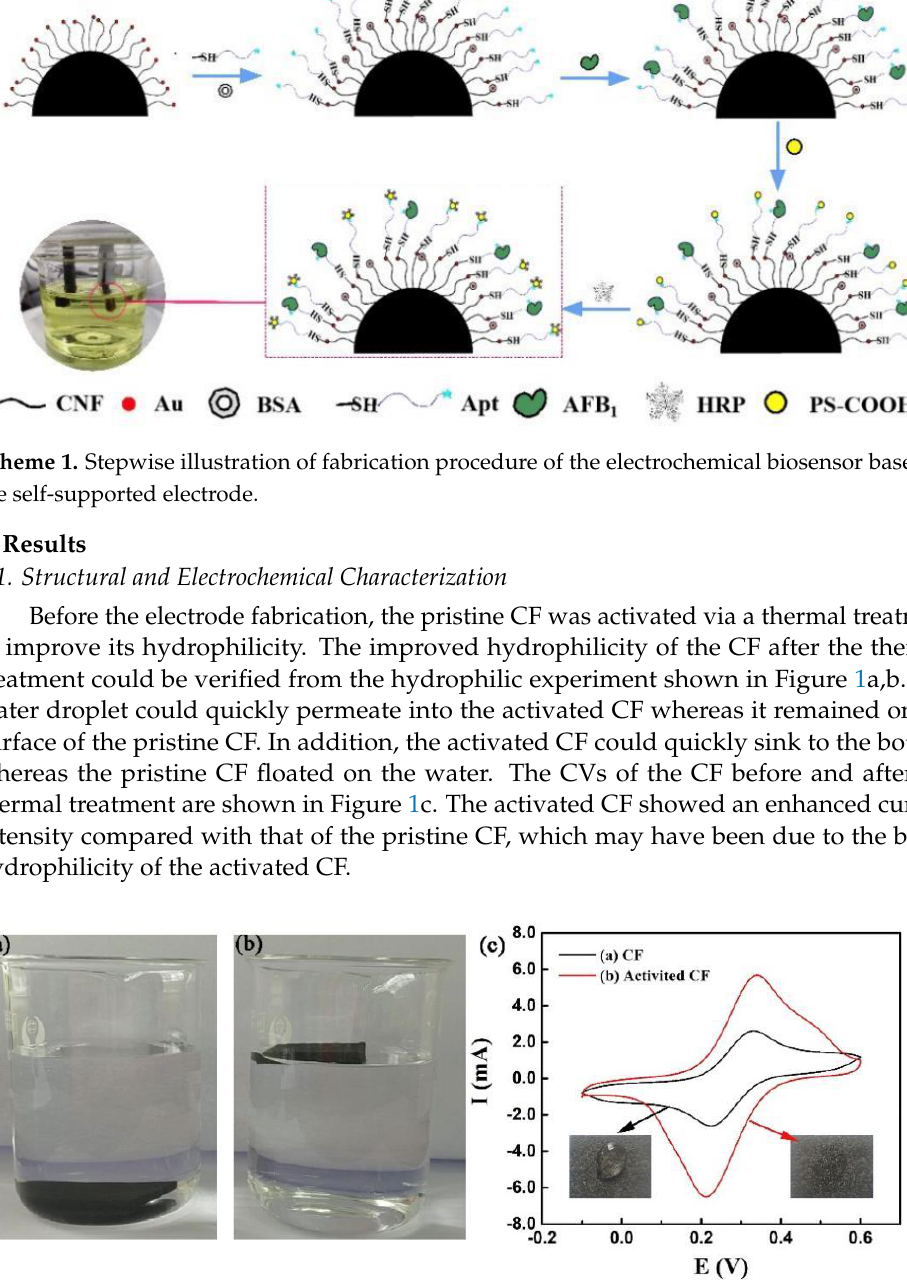
Figure 1. Digital photos of the hydrophilicity of the CF materials before and after thermal